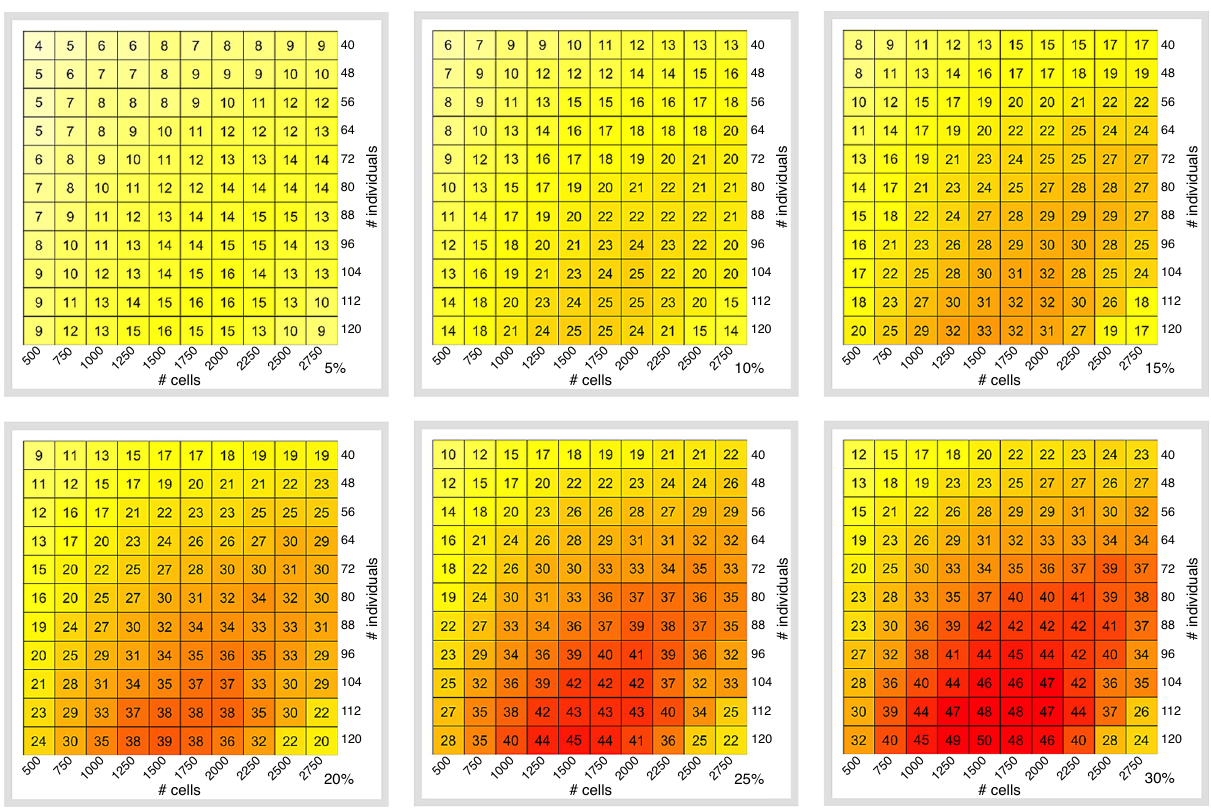
Fig. 5 Effective sample size as a function of cell-type prevalence. Shown here is the effective sample size across the grid of experimental design when the cell-type abundance is set to different values − 5, 10, 15, 20, 25, and 30%. (CD4 T cells at fi xed budget $35,000). Color scales correspond to the magnitude of the values in each cell of the